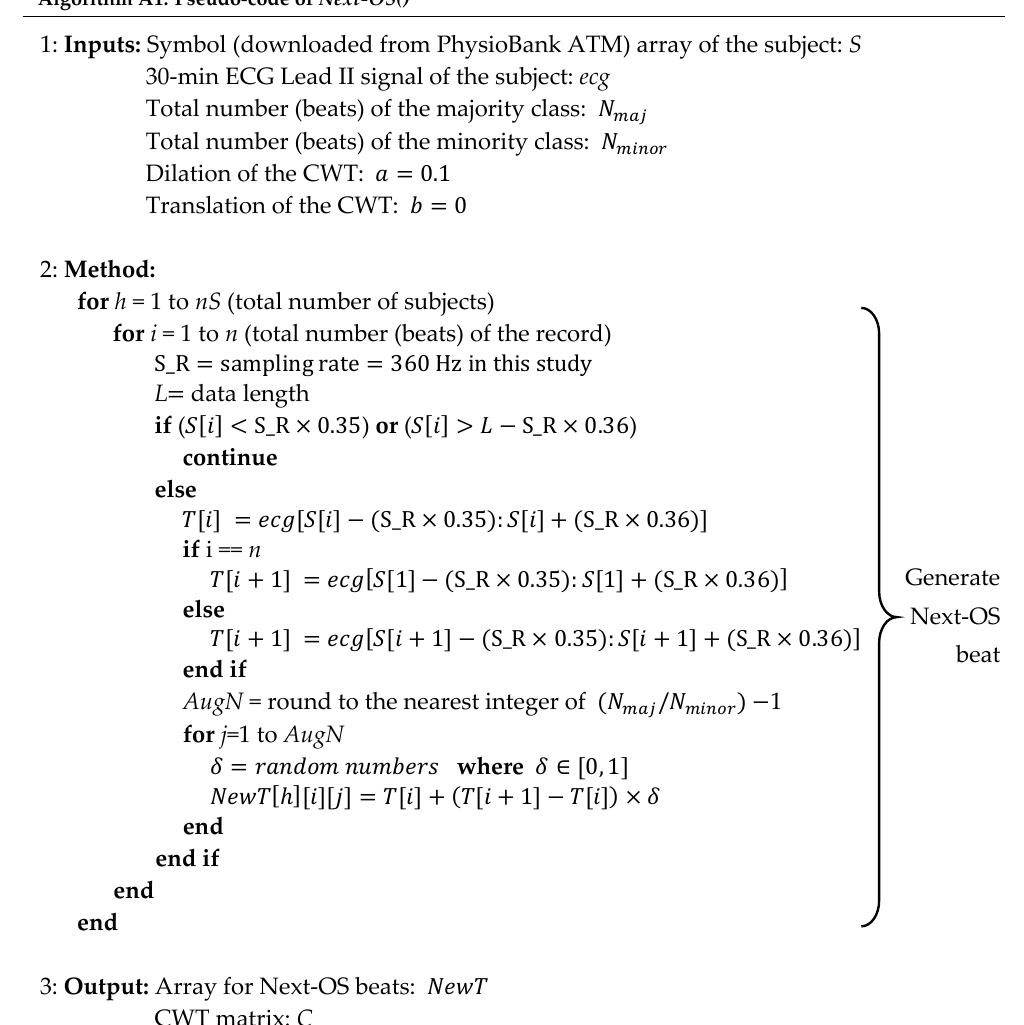
Table A1. Next-OS algorithm. Algorithm A1. Pseudo-code of Next-OS() Algorithm 1. Pseudo-code of Next-OS()